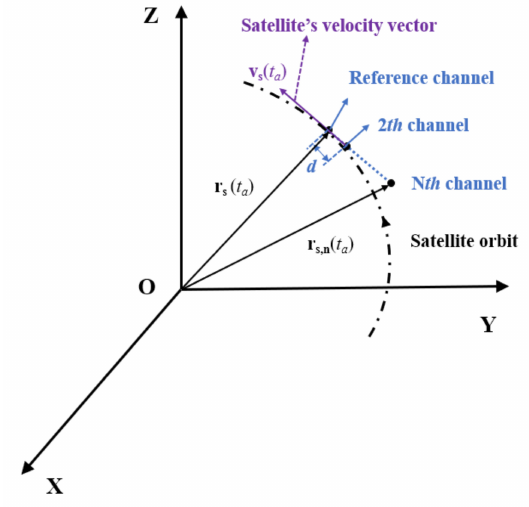
Figure 2. Geometry of the multichannel MEO